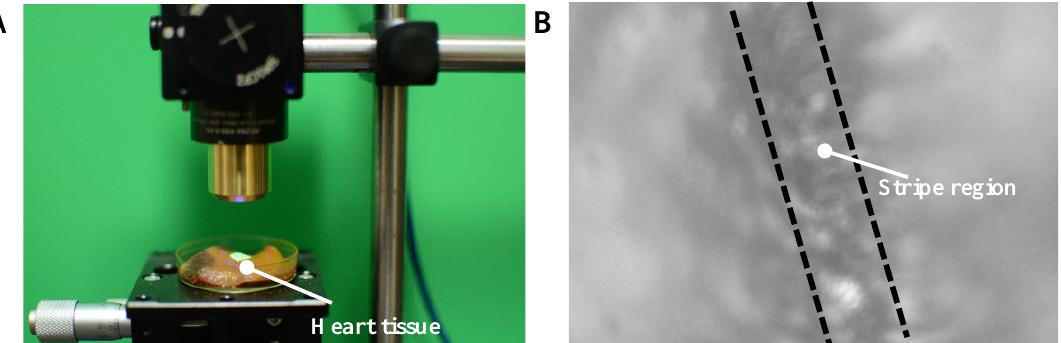
Figure 11. Calibration experiment. ( A ) A piece of heart tissue (pig) is placed in a dish and put on a 1-axis translation stage. Then the tissue is moved up by a step of length of 0.5 mm and the corresponding position of stripe is recorded in the image coordinate system. Above process repeated until the stripe moves from rightmost margin to the leftmost margin of the captured image. ( B ) Typical image of heart tissue recorded by the laboratory-built prototype during calibration experiment.